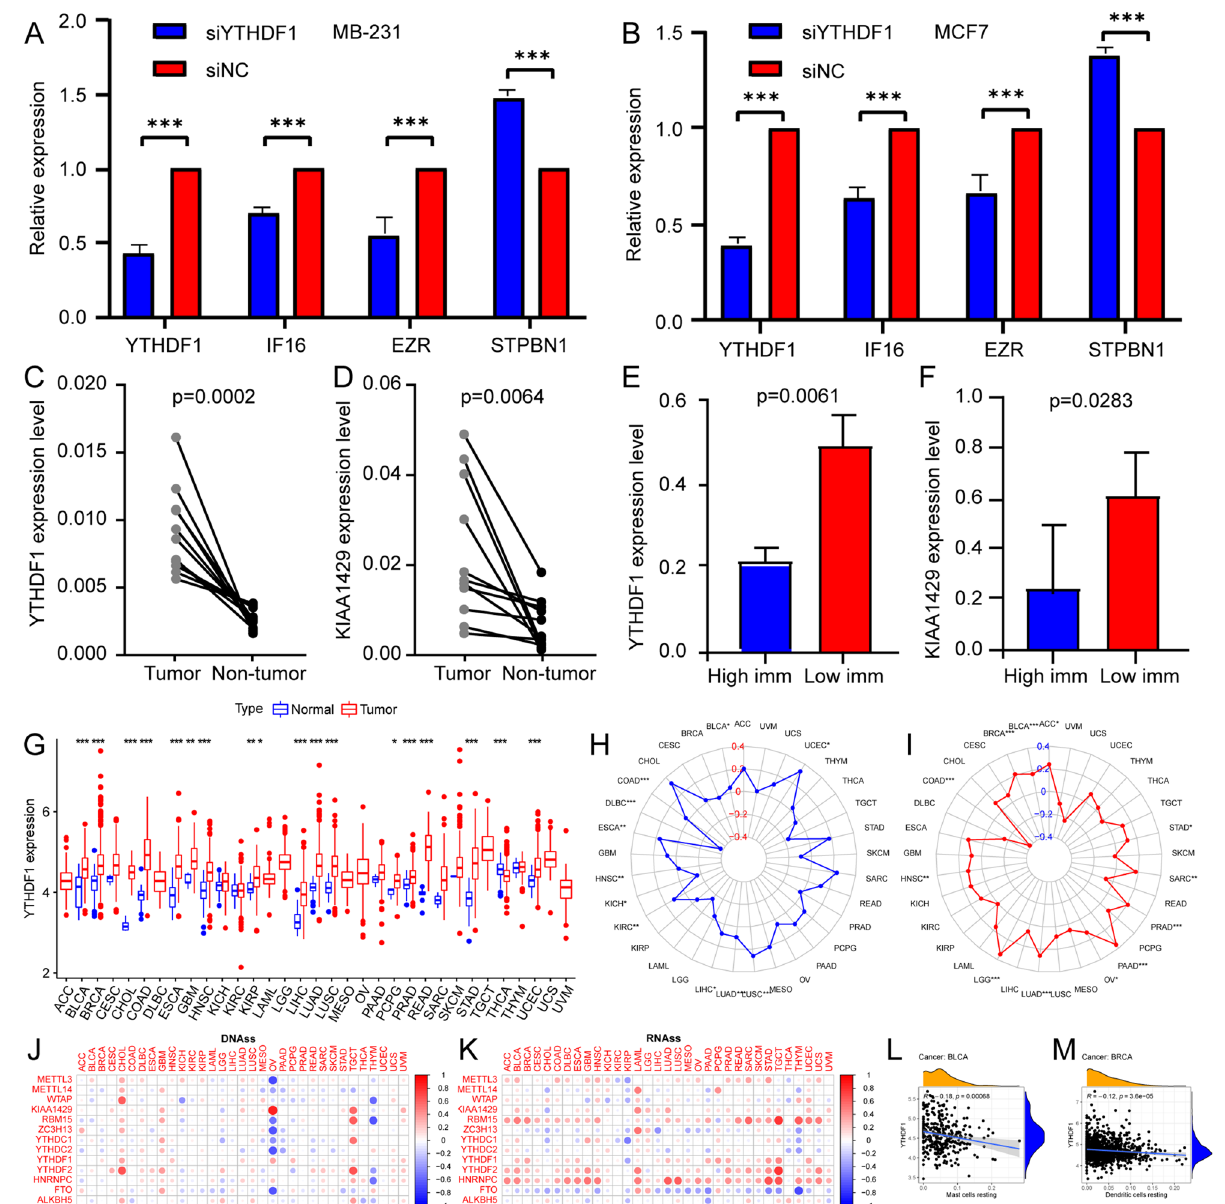
and KIAA1429 expression levels in high and low immunity group. High imm stands for high immunity group. Low imm stands for low immunity group. ( G ) The expression of YTHDF1 in pan-cancer. Blue represents normal tissue and red represents cancer tissue. ( H,I ) Correlation between YTHDF1 expression and microsatellite instability ( H ) and tumour mutation burden ( I ) in pan-cancer. ( J, K ) Relationship between the DNA ( J ) and RNA ( K ) stemness scores and m6A regulators expression levels in pan-cancer. ( L,M ) Correlation between YTHDF1 expression and immune cell infiltration in pan-cancer. ( L ) Mast cells resting in bladder urothelial carcinoma. ( M ) Dendritic cells resting in breast invasive